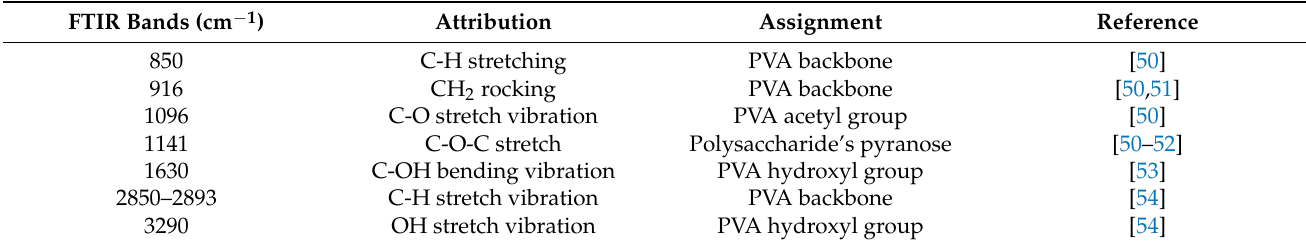
Table 1. FTIR attribution bands of PVA control